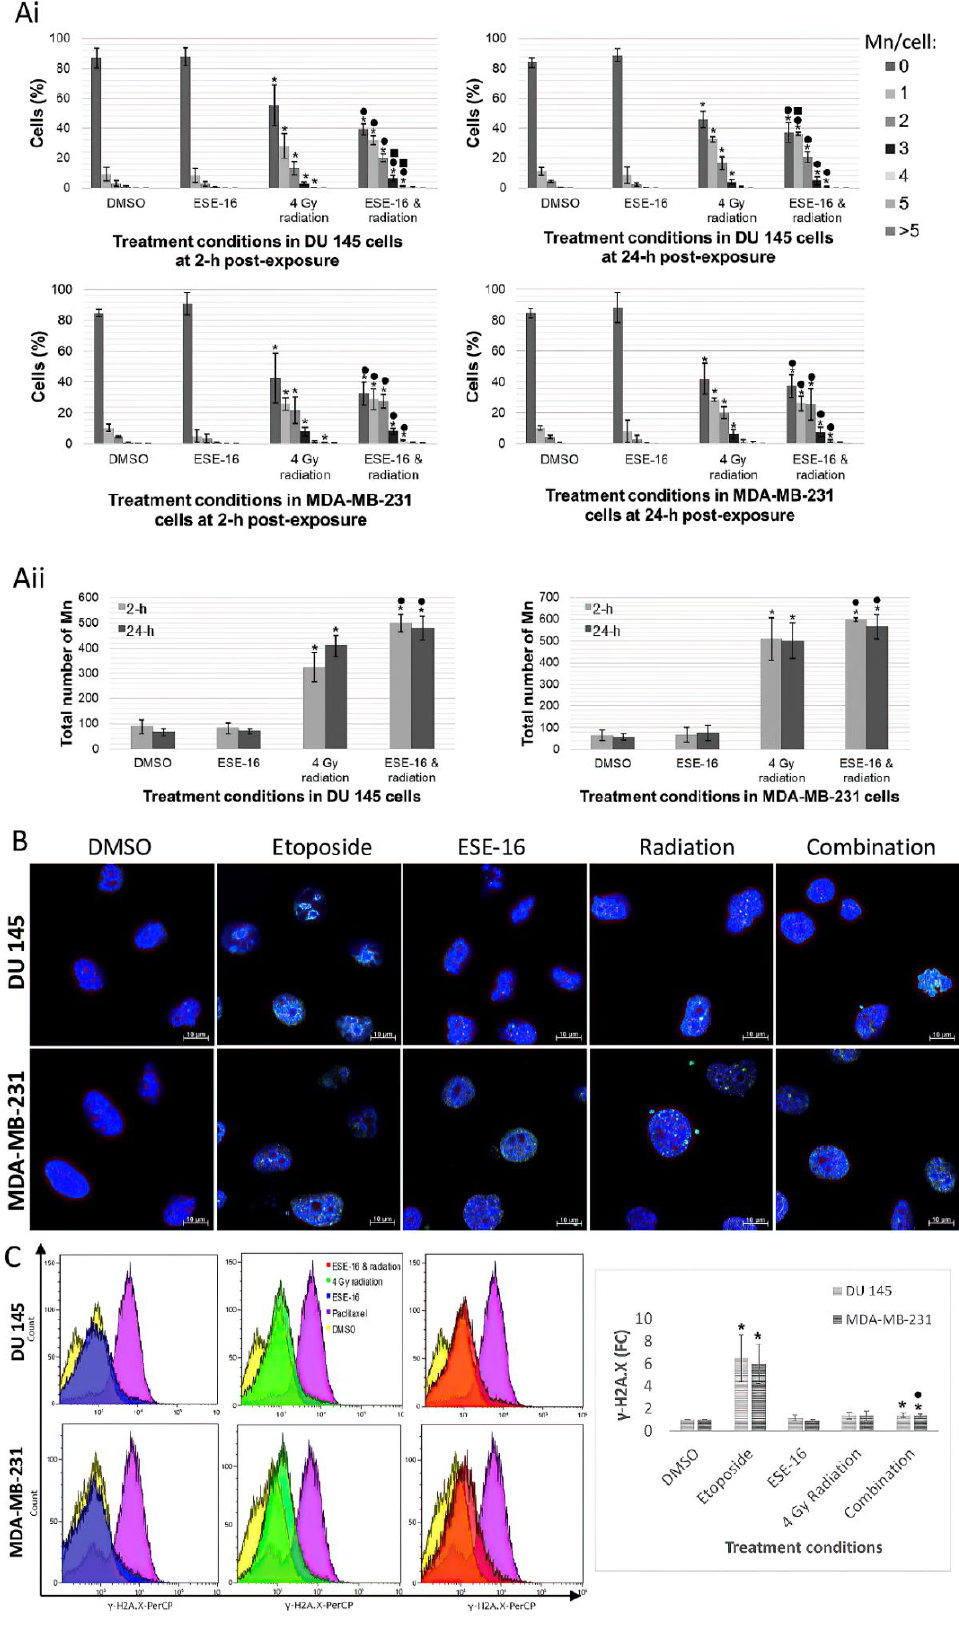
Figure 5. Investigation of DNA damage via Mn and histone H2A.X phosphorylation (γ-H2A.X). ( A ) Mn analyses of DU 145 and MDA-MB-231 cells exposed to ESE-16 and 4 Gy radiation at 2 and 24 h post-treatment. The 4 Gy radiation and